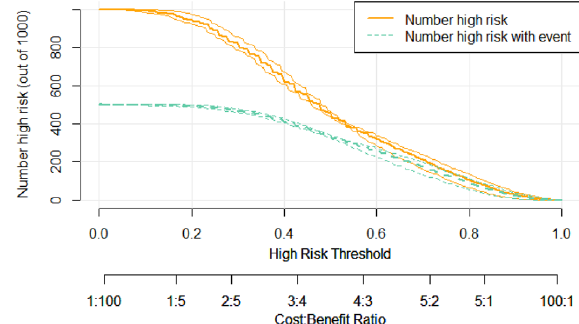
Figure 4. Clinical impact curves.